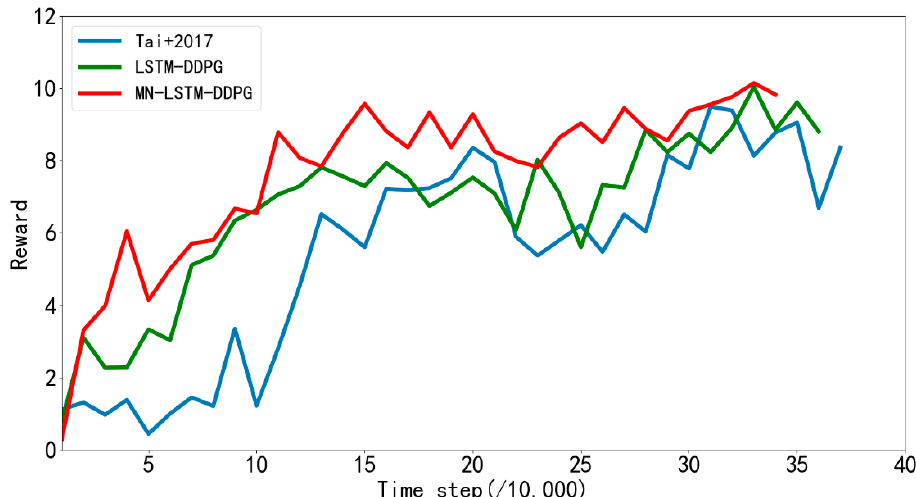
Figure 11. Average reward returned by reference [31] and the improved algorithm every 10,000 steps